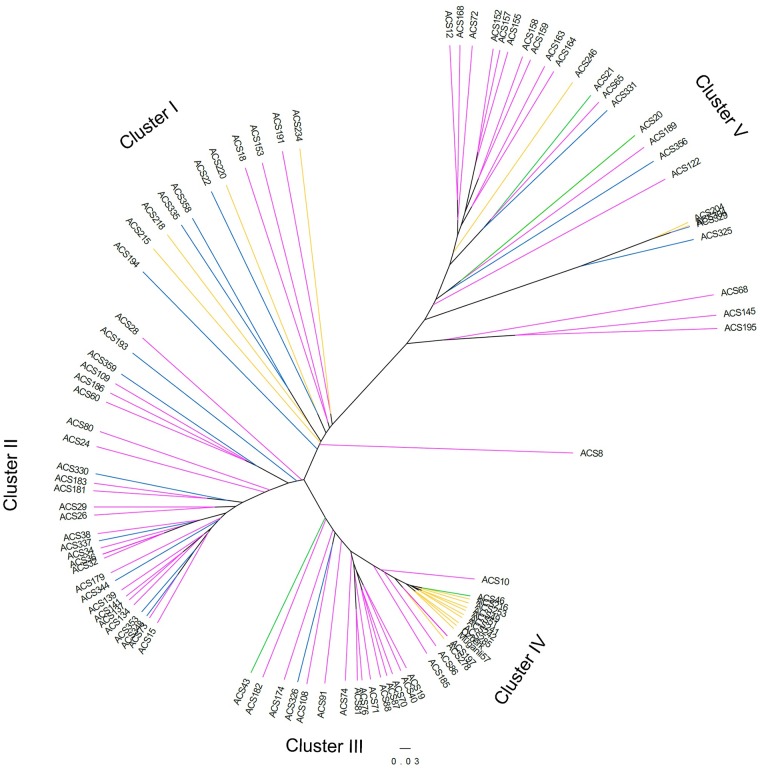
UPGMA based dendrogram generated using 5292 SNPs and 95 sesame accessions.The colors of pink, green, blue and yellow represent continental origins of accessions. Pink is Asia; Green is Africa; Blue is America; Yellow is Europe.